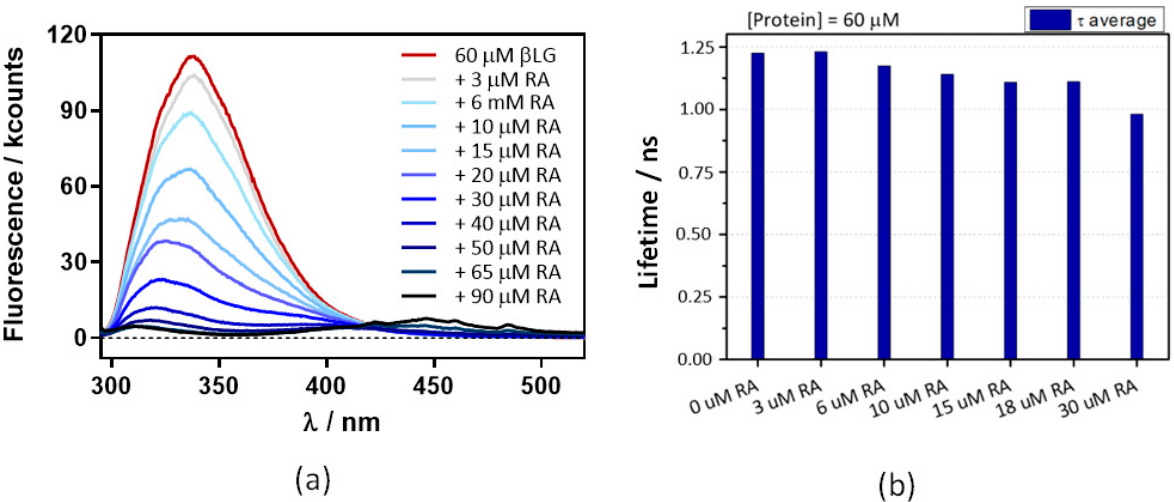
Figure 8. Decreases in β -lactoglobulin ( β LG) fluorescence intensity ( a ) and lifetime ( b ) with increasing concentrations of retinoic acid (RA). The β LG concentration fixed at 60 µ M, excitation was at 280 nm, and detection at 340 nm. The fluorescence showed a multiexponential decay, thus the amplitude-averaged decay lifetime is plotted.